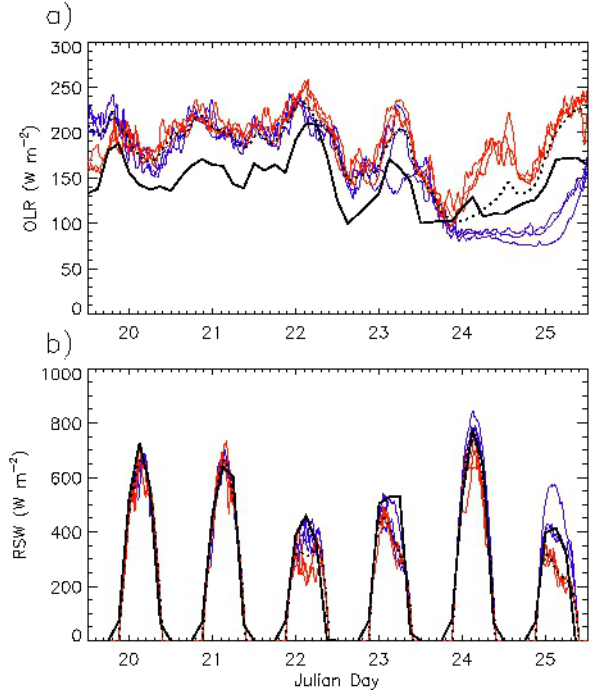
Fig. 2. Timeseries of horizontally-averaged TOA (a) outgoing long- wave radiation (OLR) and (b) reflected shortwave radiation (RSW) for the three low-OLR (blue) and three high-OLR (red) realiza- tions. Observations are indicated by the solid black lines, and the ensemble-mean OLR and RSW are indicated by the dotted black